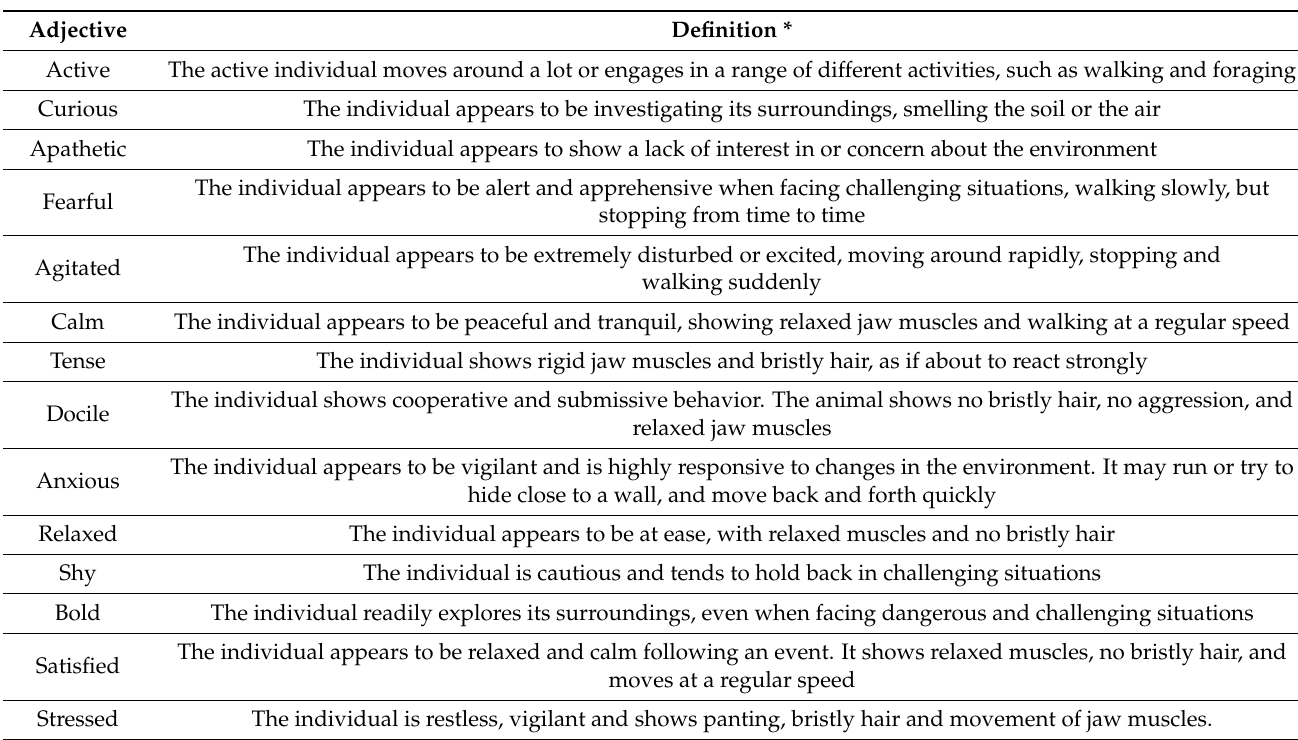
Table 1. List of adjectives definitions used to evaluate the paca’s temperament